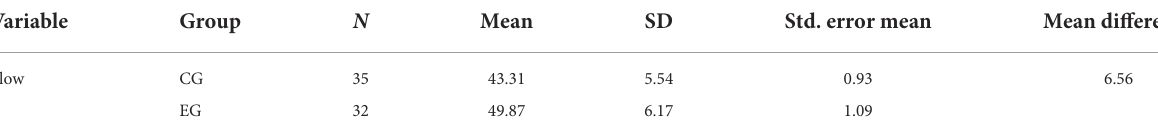
TABLE 5 Descriptive statistics of flow posttest scores.